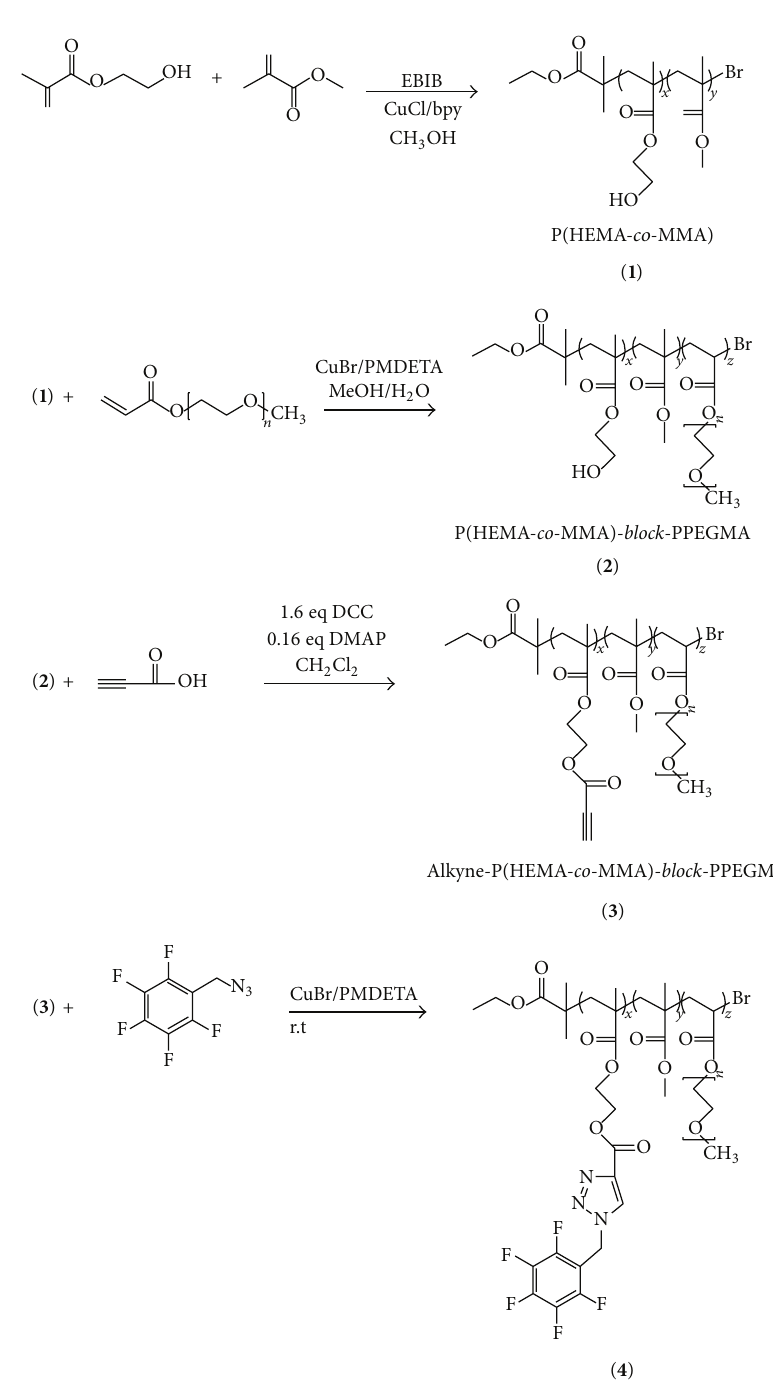
Figure 2: Synthesis of alkyne-P(HEMA- co -MMA)- block -PPEGMA ( 3 ) and its click coupling reaction ( 4